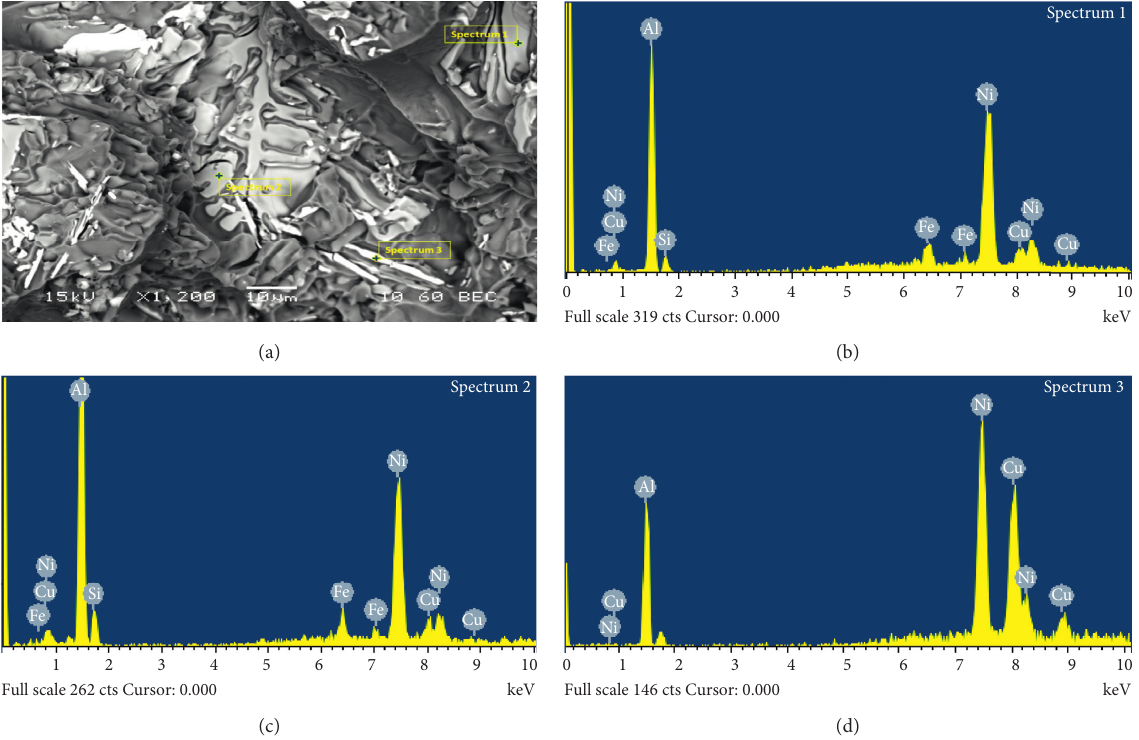
Figure 7: (a) High magnification of the circled area shown in Figure 6 (a), (b) and (c), and (d) EDS spectra showing the chemical composition of the cracked phases in